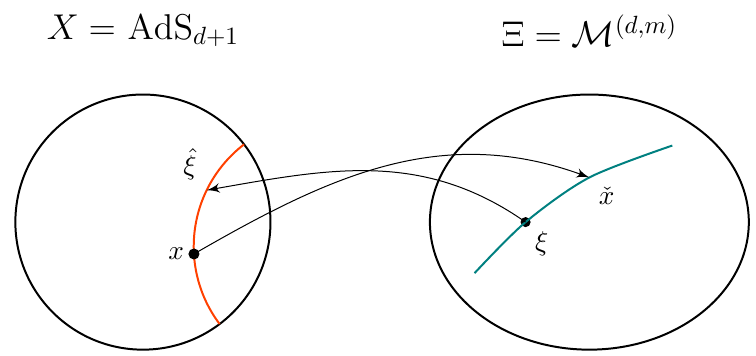
Figure 1 . The Radon transform between the AdS space and the moduli space M ( d;m ) of conformal